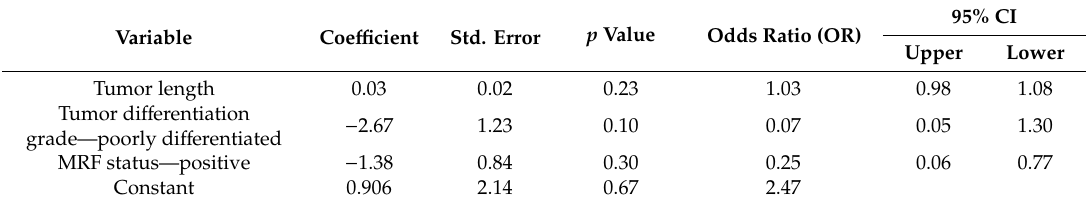
Table 4. Multivariate logistic regression analysis for the prediction of the non-responders—semantical- pathological model.